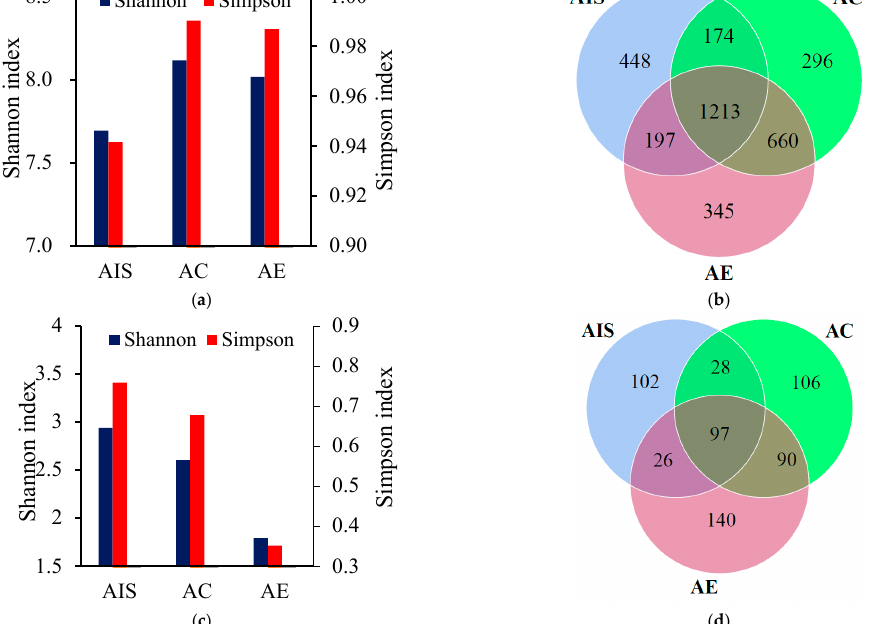
Figure 2. α diversity of active bacteria ( a ); eukaryotes ( c ); Venn diagram of active bacteria ( b ); eukaryotes ( d ) in initial sludge (AIS); final products of control (AC); vermicompost (AE). All data were based on OUT results.